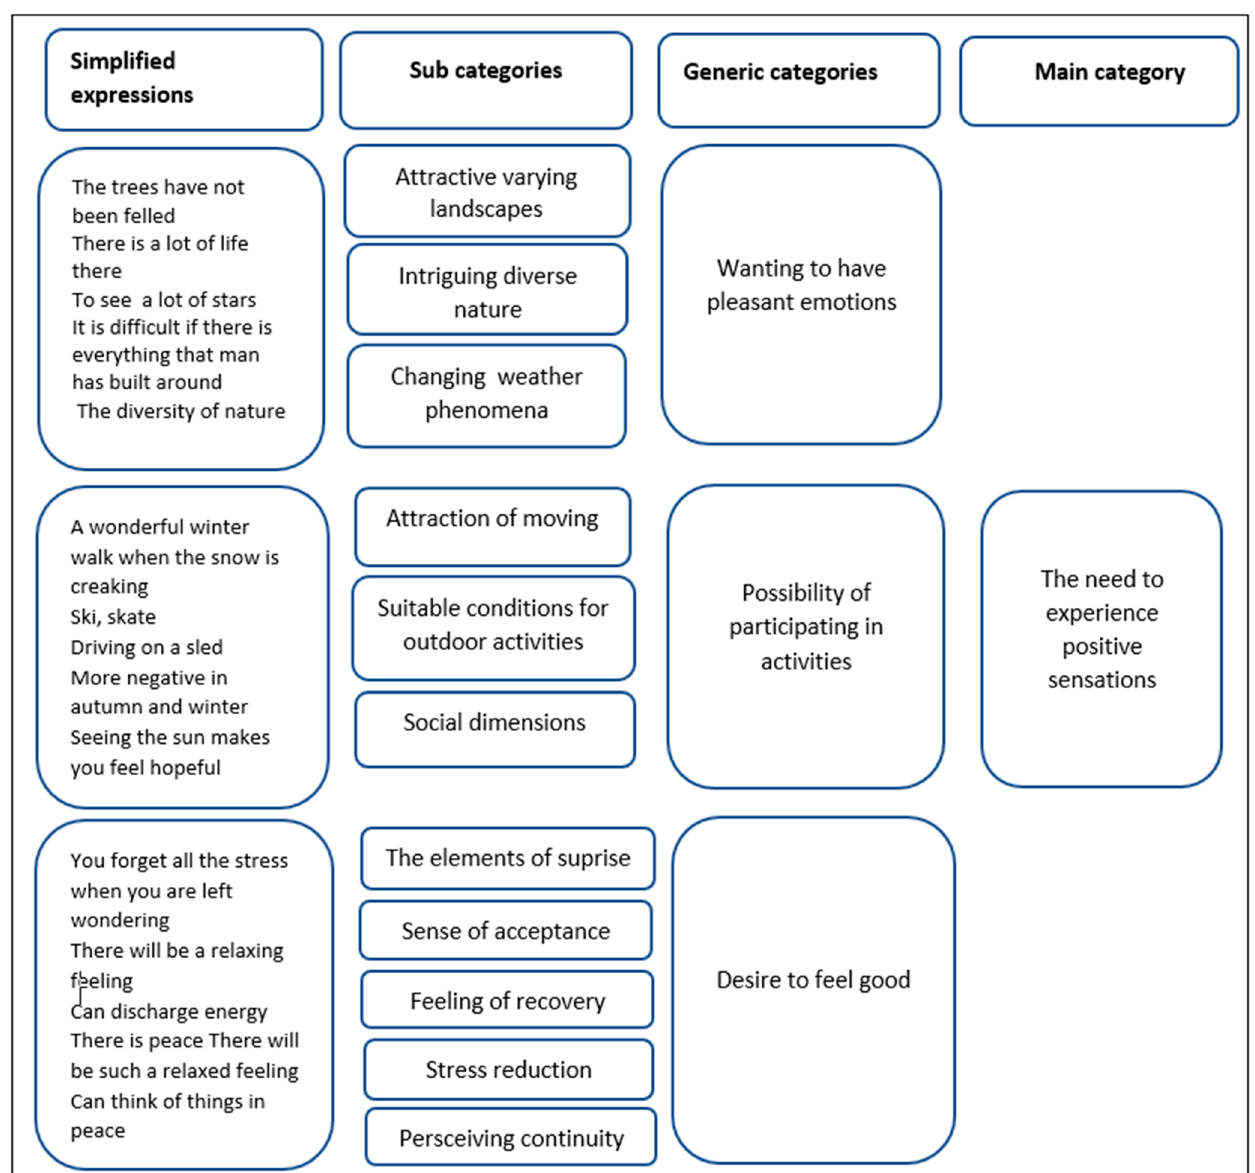
Figure 2. Illustration of the data analysis process showing the grouping of subcategories to form generic categories, and the main category: “the need to experience positive sensations.”